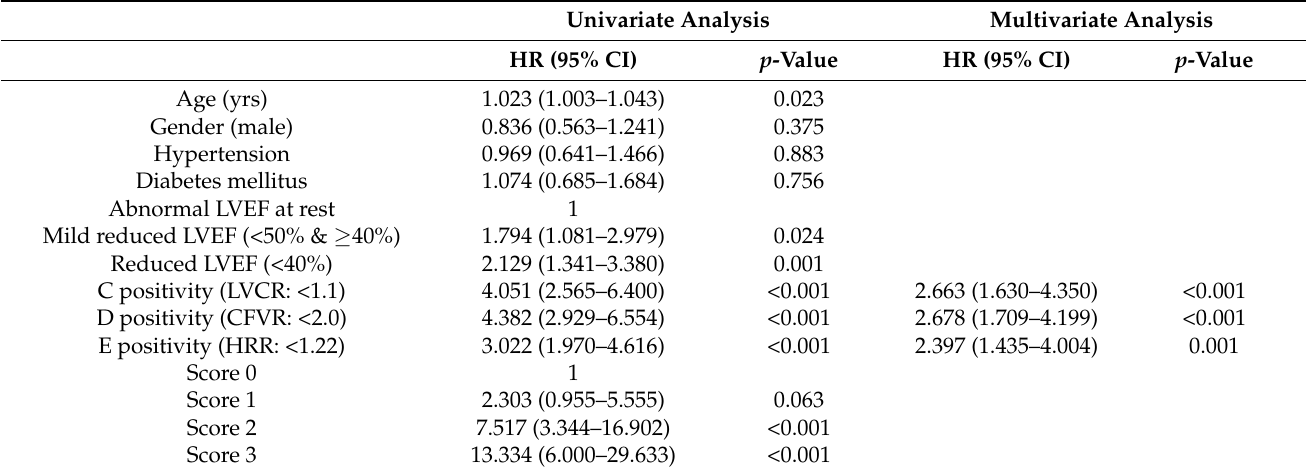
Table 4. Univariate and multivariate predictors of hard events. Univariate